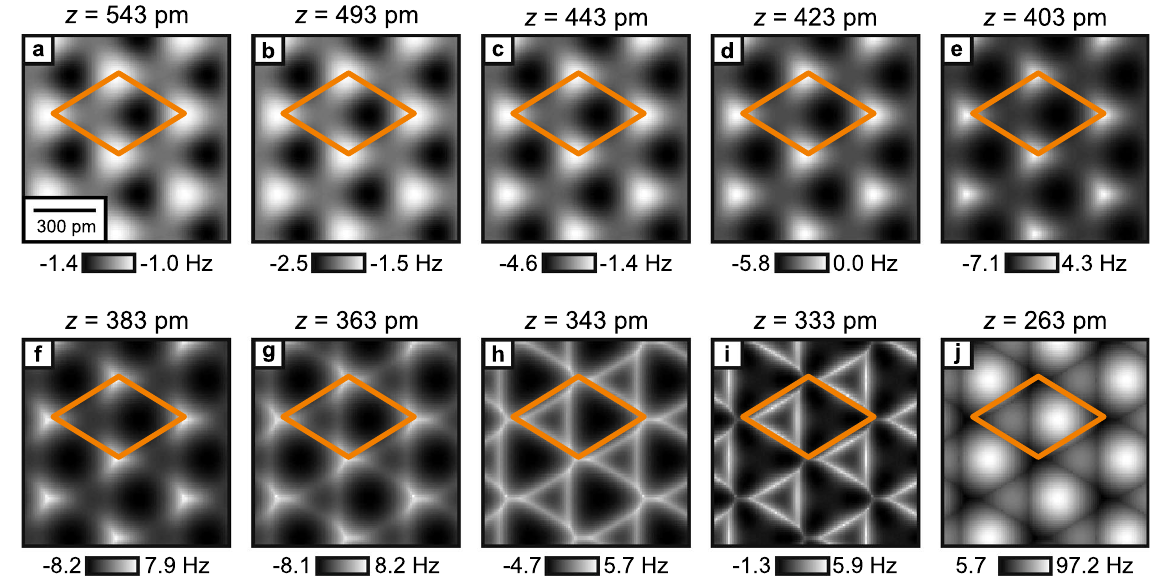
Figure 5. Calculated z -dependent constant-height images created with the probe particle model using the standard choice of Lennard–Jones potentials to describe van der Waals attraction and Pauli repulsion. The unit cell defined in Fig. 1f is drawn in all